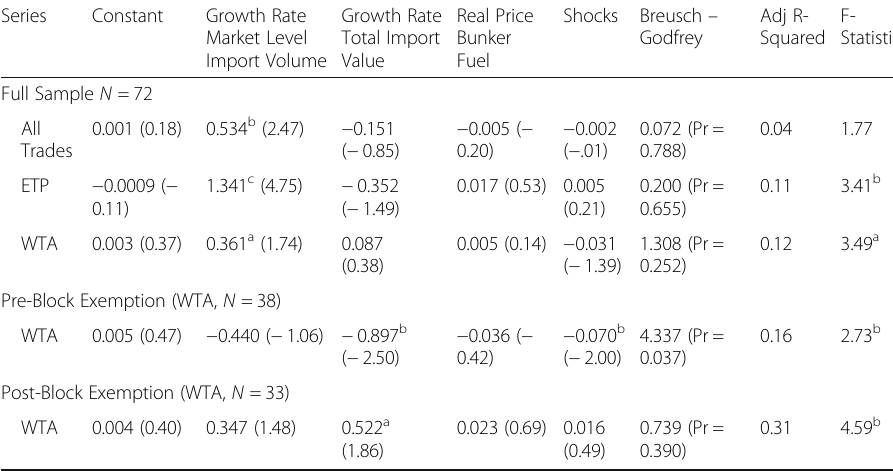
Adj R- F- Squared Statistic